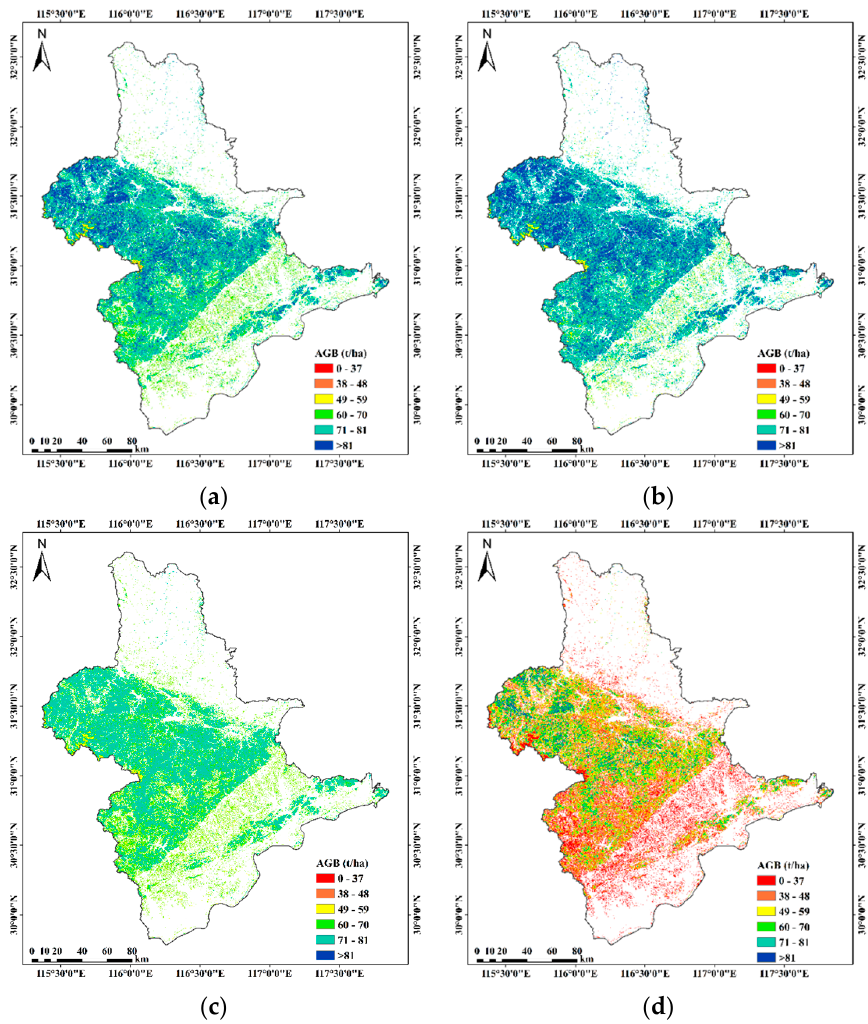
Figure 4. AGB estimation retrieved by the four modeling algorithms: ( a ) SVM, ( b ) RF, ( c ) BPNN, and ( d ) SMR.